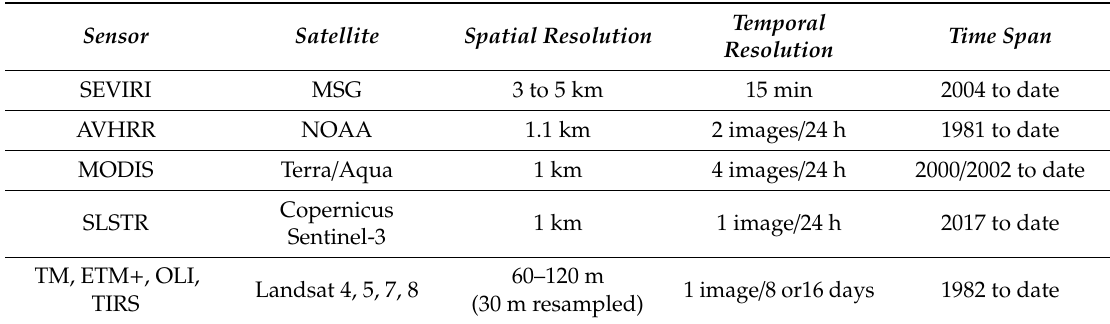
Table 1. Characteristics of satellite remote sensing products delivering Land Surface Temperature